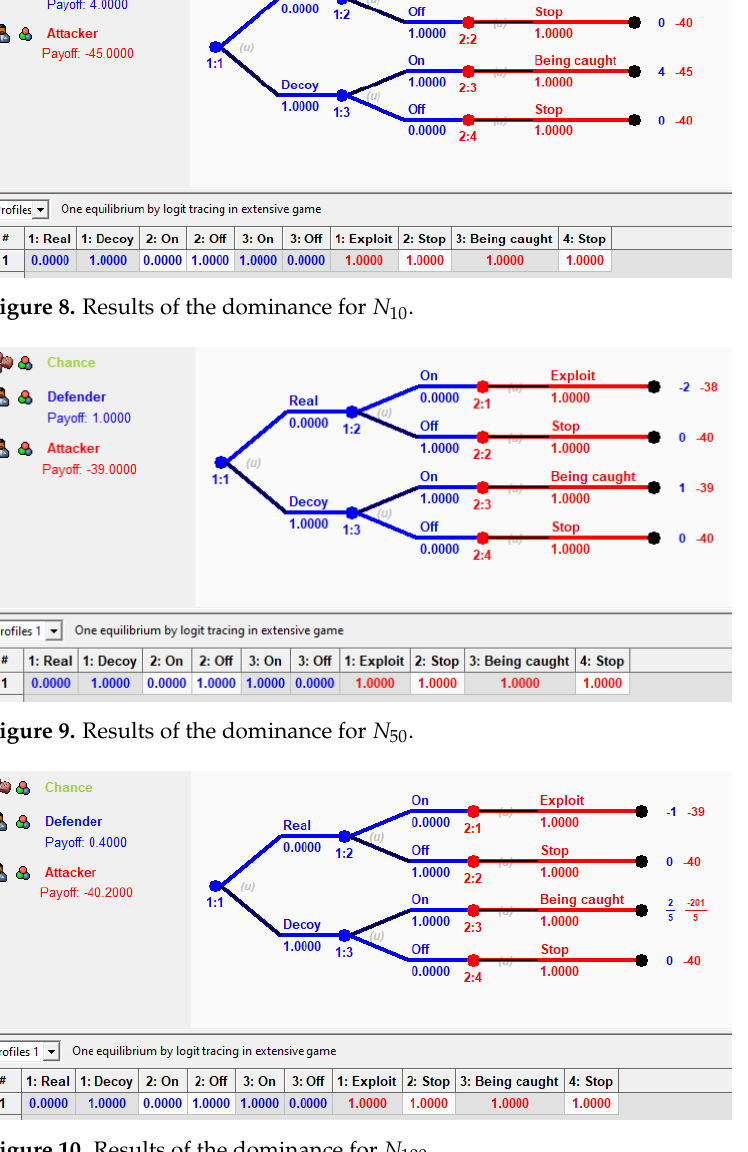
Figure 10. Results of the dominance for N 100